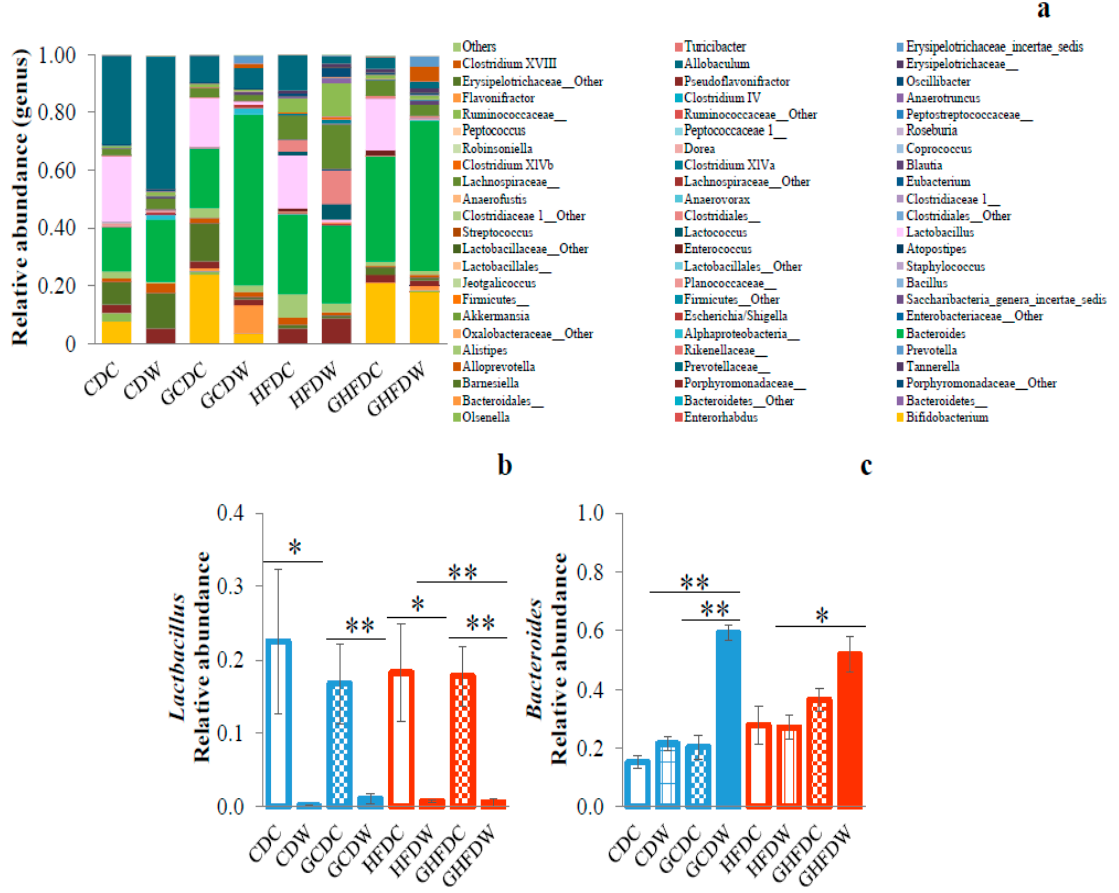
Figure 6. The supplemental effect of wheel running on gut microbiota at genus level in PHGG intake mice under CD and HFD-feeding. Relative abundance at genus level ( a ), Lactobacillus ( b ), and Bacteroides ( c ) after 10 weeks. The values were expressed as the mean ± S.E.M. * p < 0.05 and ** p < 0.01.